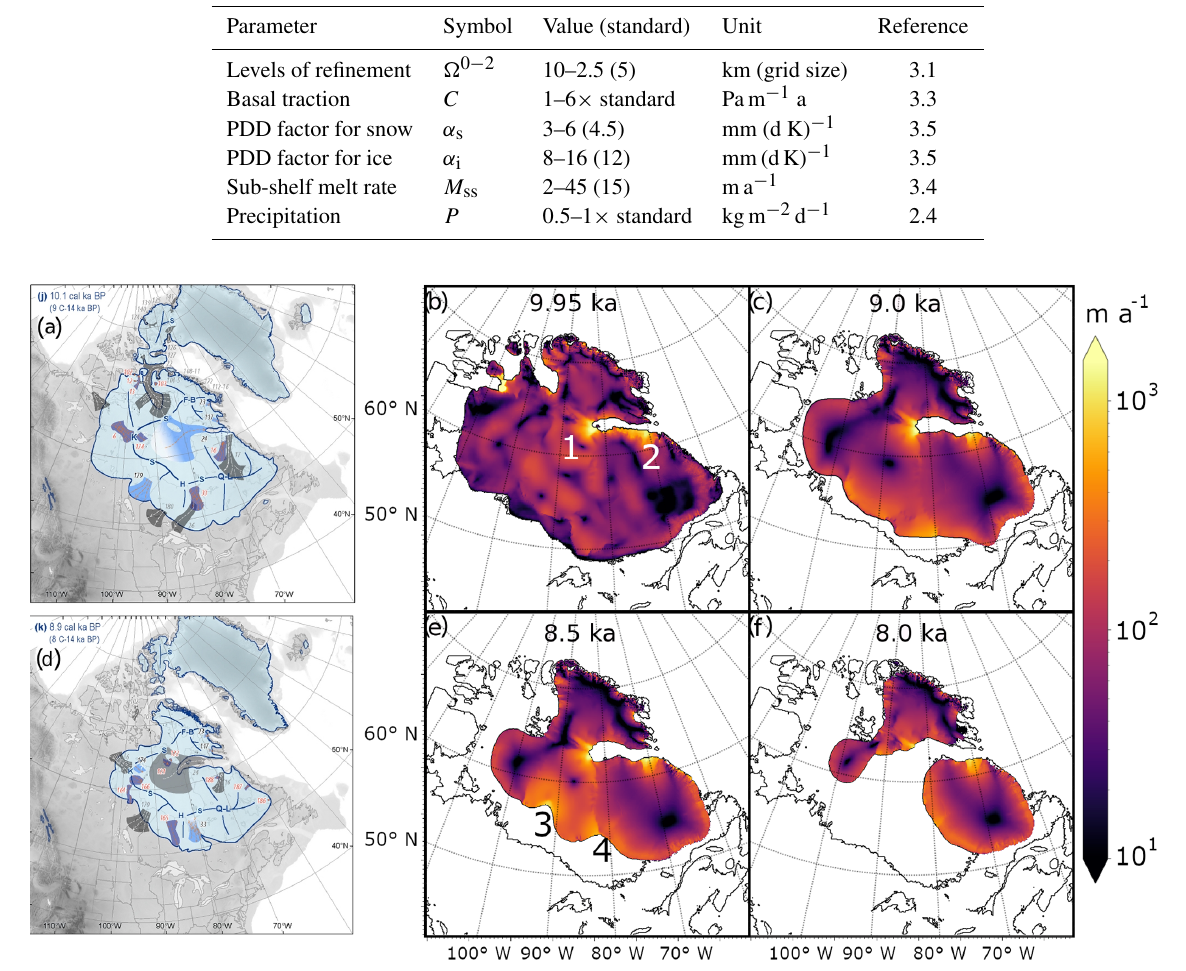
Figure 3. Comparison of modelled and observed ice stream activity. Reconstruction of LIS ice stream activity at 10.1ka (a) and 8.9ka (d) (adapted from Fig. 5 in Margold et al., 2018). The ice streams that were active at the respective times are shown in light blue, ice streams that “switched off” in the preceding 1000 years are shown in grey, and those that “switched on” are shown in dark blue. Panels (b) , (c) , (e) and (f) show the magnitude of depth-integrated velocities (ma − 1 ) in the standard simulation at 9.95, 9.00, 8.5ka and at the end of the simulation (8.00ka), respectively. In the panels showing the simulated ice velocities, modern coastlines are indicated by the black contour. The numbers 1 and 2 in panel (b) and numbers 3 and 4 in panel (e) show the approximate locations of four major reconstructed ice streams and correspond to locations numbered 24, 16, 179 and 33 in Fig. 5 in Margold et al. (2018),